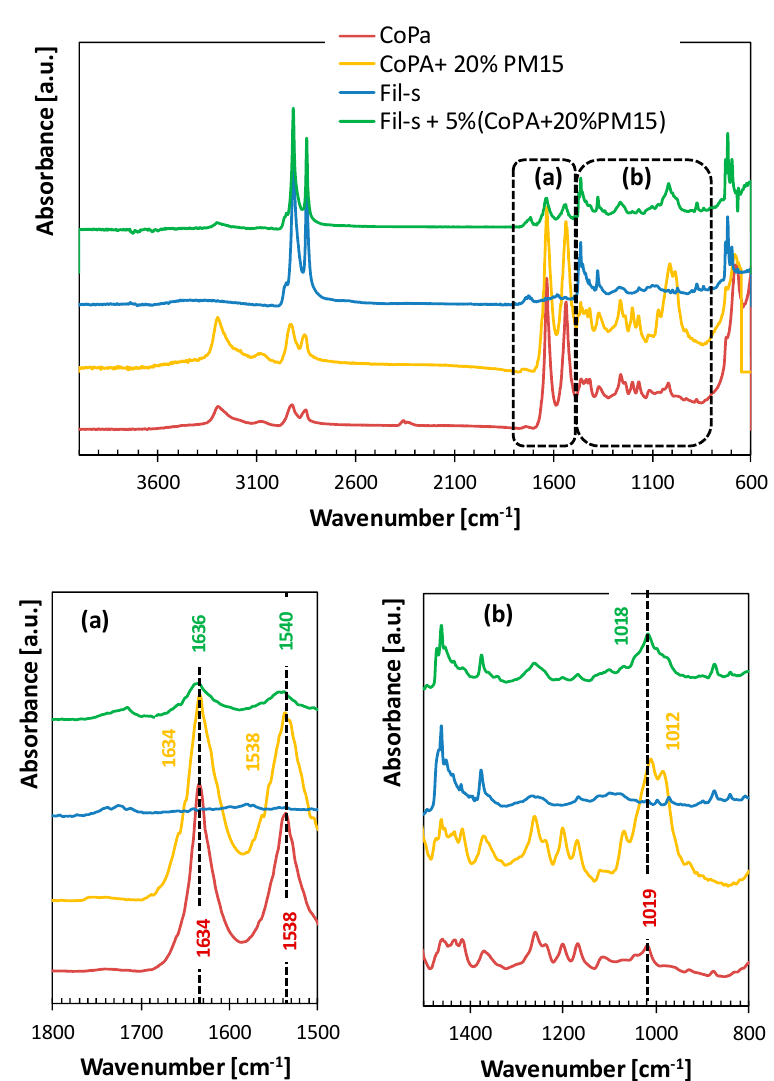
Figure 5. Comparison of FTIR / ATR spectra of Fil-s, neat copolyamide, copolyamide masterbatch, and Figure 5 . Comparison of FTIR/ATR spectra of Fil-s, neat copolyamide, copolyamide masterbatch, and the blend Fil-s + 5%(CoPA + the blend Fil-s + 5%(CoPA + 20%PM15).